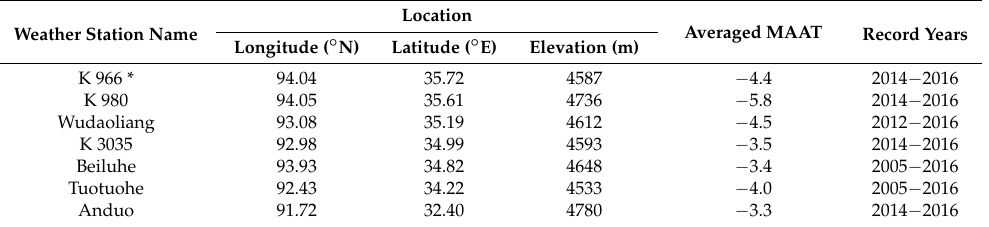
Table 2. Locations of the weather stations and number of years with